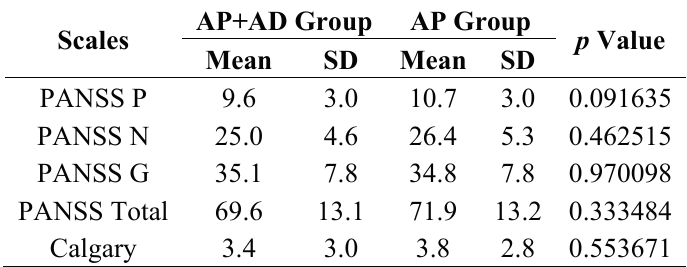
Table 2. Results of Positive and Negative Syndrome Scale (PANSS) and Calgary scales in each group.